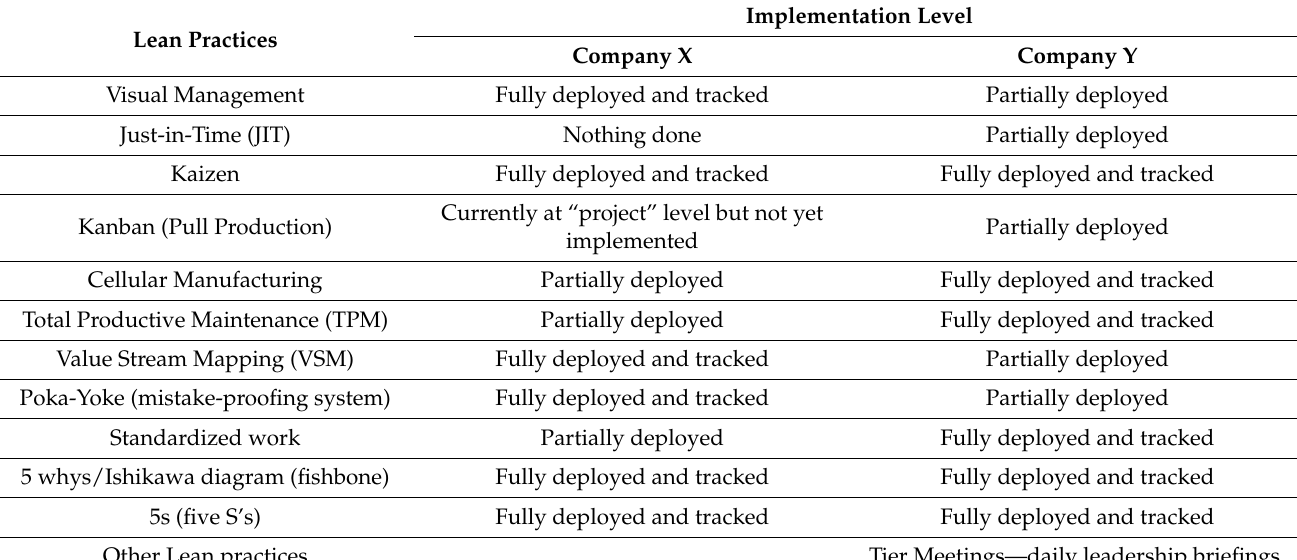
Table 2. The companies’ lean practices.